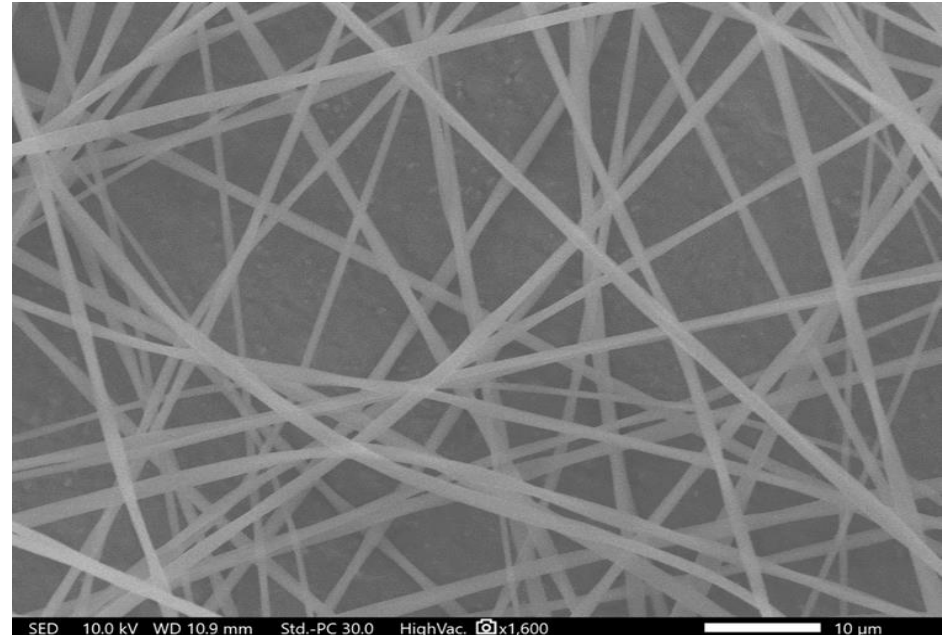
Figure 1. Drug-loaded electrospun fibers showing a smooth, un-beaded, and un-porous appearance of the yielded fibers indicating their successful preparation.